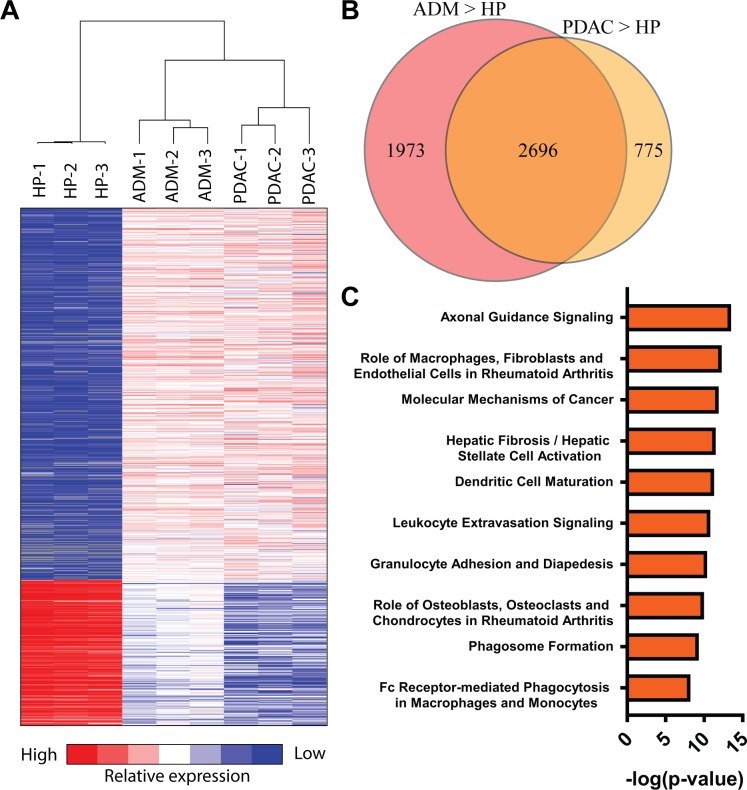
RNA sequencing of microdissected regions of ADM and PDAC identifies differentially expressed genes and pathways.(A) Heatmap depicting normalized gene expression of differentially expressed genes in three way comparison between HP, ADM and PDAC samples. (B) Venn diagram depicting overlap between differentially expressed genes in HP-ADM and HP-PDAC pair wise comparisons. (C) IPA canonical pathway analysis identifies conserved inflammation associated canonical pathways present in ADM and PDAC. Data is represented as negative log (P value) of canonical pathway association.